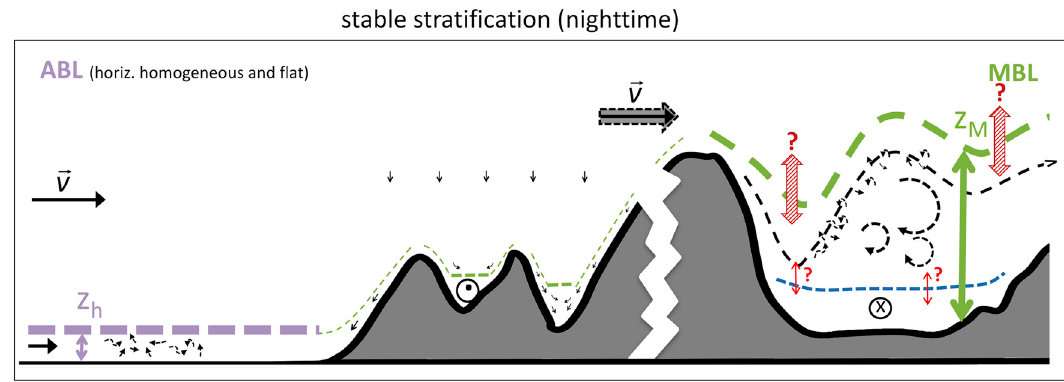
Figure 4. As Figure 2, but for nighttime (stable stratification); indication of exchange between different layers only tentative (and with question marks). The right-hand side (MBL) distinguishes between light ambient-wind conditions upwind of the second peak and stronger ambient wind downwind, symbolized by the heavy gray horizontal wind vector. The meaning of the individual lines and arrows is identical to Figure 2. Blue dashed lines are displayed in green if z iv corresponds to z M (upwind of the main peak). Synoptic wind is from the left. The flow direction in the valleys is down-valley ( ⊙ ) under quiescent ambient conditions, with the valley sloping into the page. Up-valley flows are possible , as indicated by the ⊗ -symbol downwind of the major peak. The upwind (quiescent) portion of the MBL is based on Zardi and Whiteman [58] and Lareau et al. [60] concerning slope flows and cold air pools. The downwind (dynamically modified) side is based on ‘scenario B’ in Strauss et al. [61]. Note that the terrain has been changed in the downwind portion with respect to Figure 2, because the typical scale of the valley must be large enough to allow for the development of, e.g.,